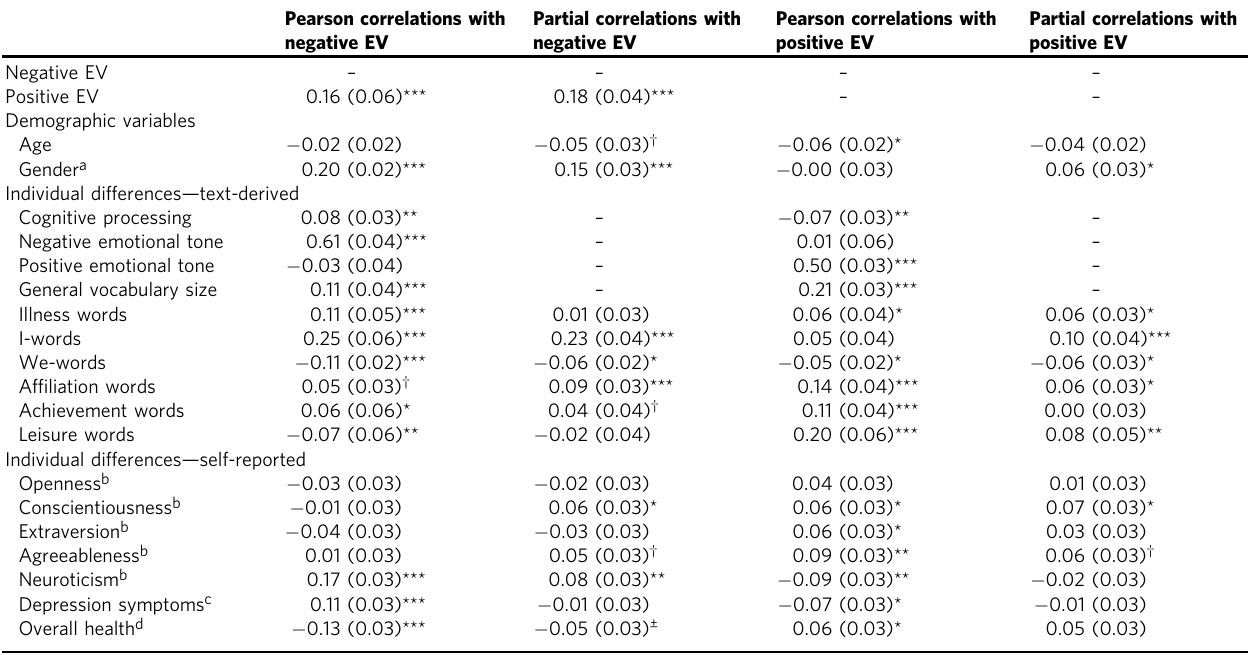
Table 1 Pearson and partial correlations of emotion vocabulary (EV) with other study variables for study 1 ( N = 1567 unless marked